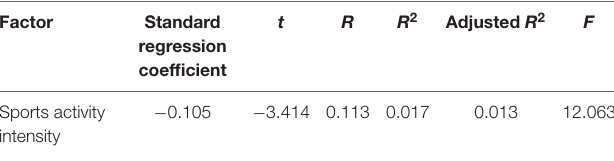
TABLE 8 | Regression analysis of sports activity participation on